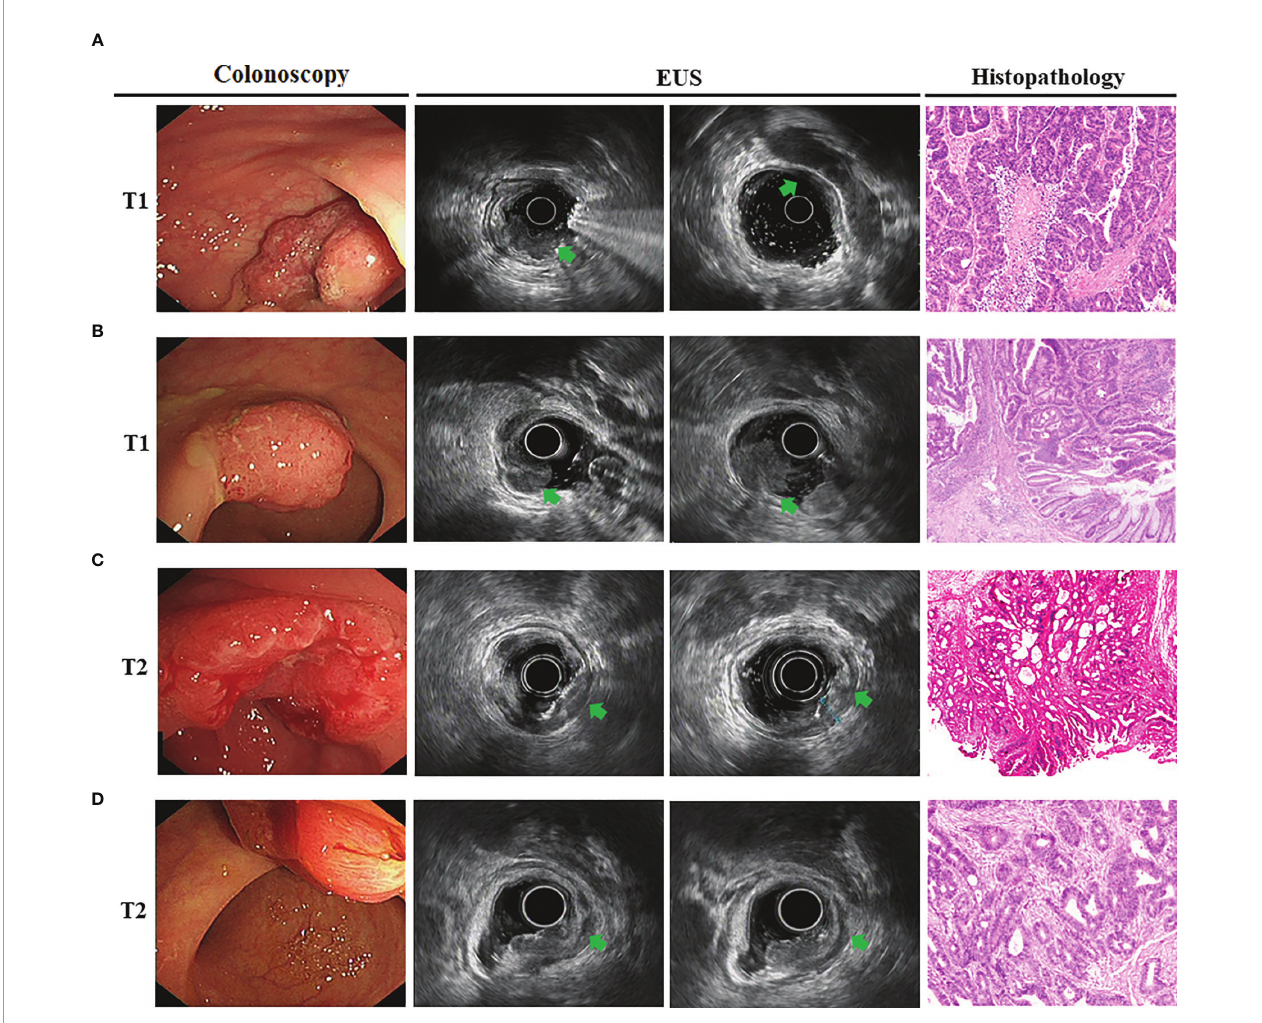
FIGURE 2 | The EUS image features for T1 and T2 tumor T stage. (A, B) . Endoscopic view of super fi cial rectal cancers. Endoscopic images showed the T1 stage lesions in fi ltrate the mucosa and muscularis mucosae, with submucosa intact ( arrowheads ). Surgical resection con fi rmed moderately-differentiated adenocarcinoma con fi ned to submucosal layer for male (A) and female (B) ; (C, D) . Gastroscopy showed neoplasms located at the rectal walls. EUS images showed disappearance of the fi rst three layers and companied by muscularis propria obvious thickening ( arrowheads ). The surgical specimen con fi rmed moderately-differentiated adenocarcinoma in fi ltrated to the muscolaris propria for male (C) and female (D)